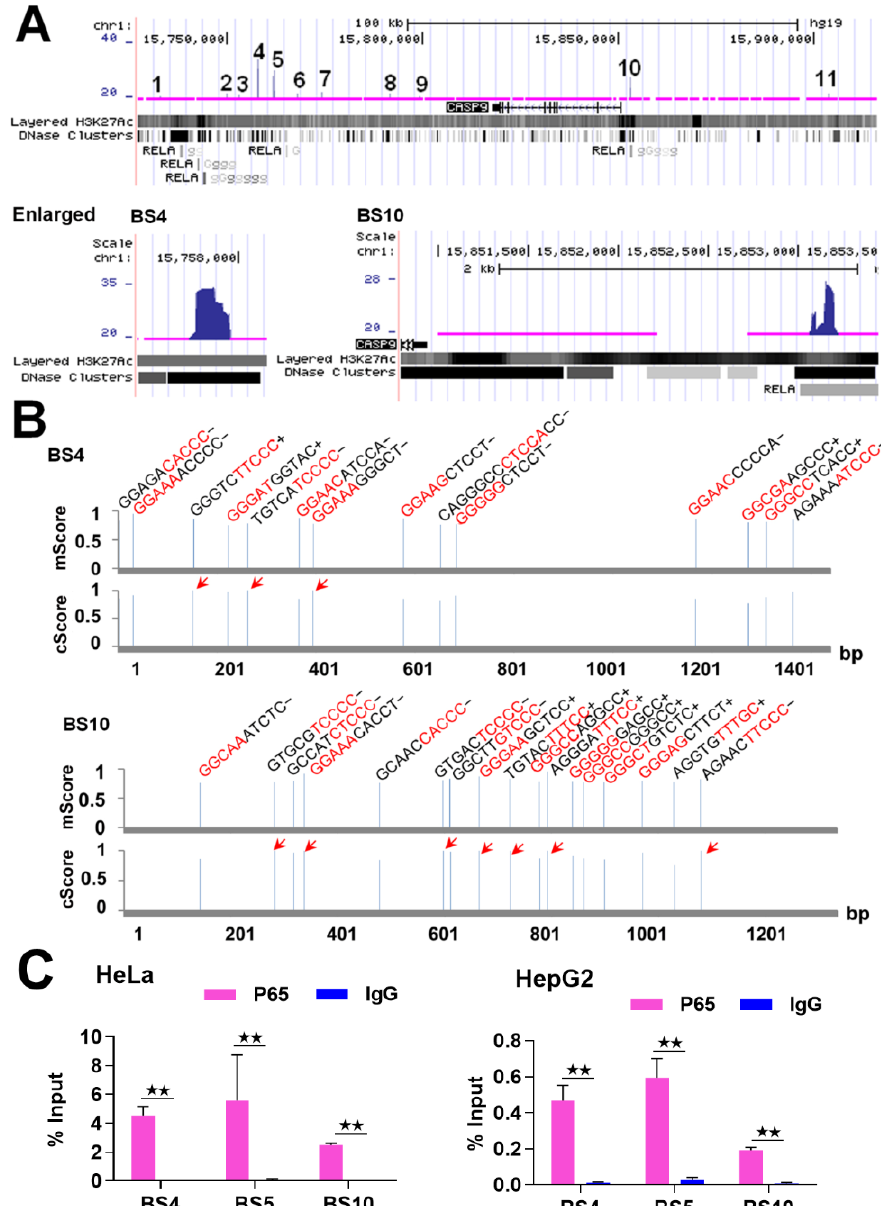
Figure 1. The binding of NF- κ B to CASP9 gene. ( A ) NF- κ B-BSs (i.e., ChIP-Seq peaks; labeled with numbers) assigned to the CASP9 gene in TNF α -treated HeLa cells. BS4 and BS10 are magnified in the image. ( B ) Predicted κ Bs in BS4 and BS10. The relative position, sequence and match score of κ Bs in the two BSs are shown. The five most conserved bases in the core match analysis are shown in red. The κ Bs with a core score of 1 are highlighted with arrows. mScore, matrix match score; cScore, core match score. ( C ) ChIP-qPCR detection of three BSs assigned to CASP9 in TNF α -treated HeLa and HepG2 cells. The data are presented as the means ± SD from at least three replicates. The significance of the di ff erence was analyzed by Student’s t-test. * p < 0.05; ** p < 0.01.